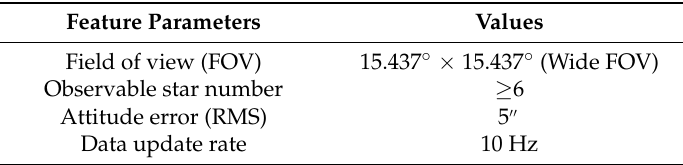
Table 5. Main parameters of SODERN SED26 star